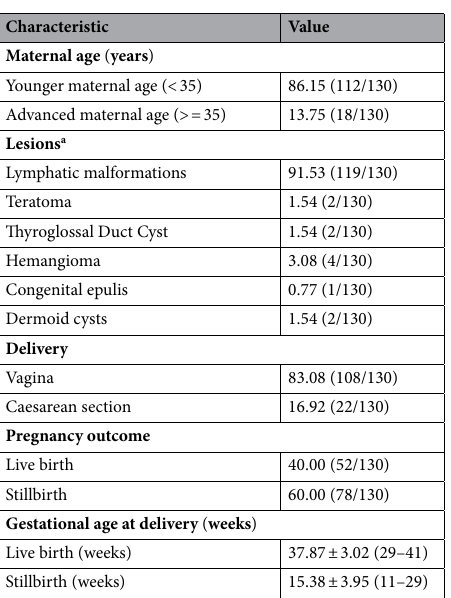
Table 1. Perinatal features of the study population derived from 130 cases of fetal facial and cervical masses. Data are given as % (n) or mean ± SD (range). a The localization of the lesion for babies is diagnosed by postoperative pathologic results, postmortem, medical